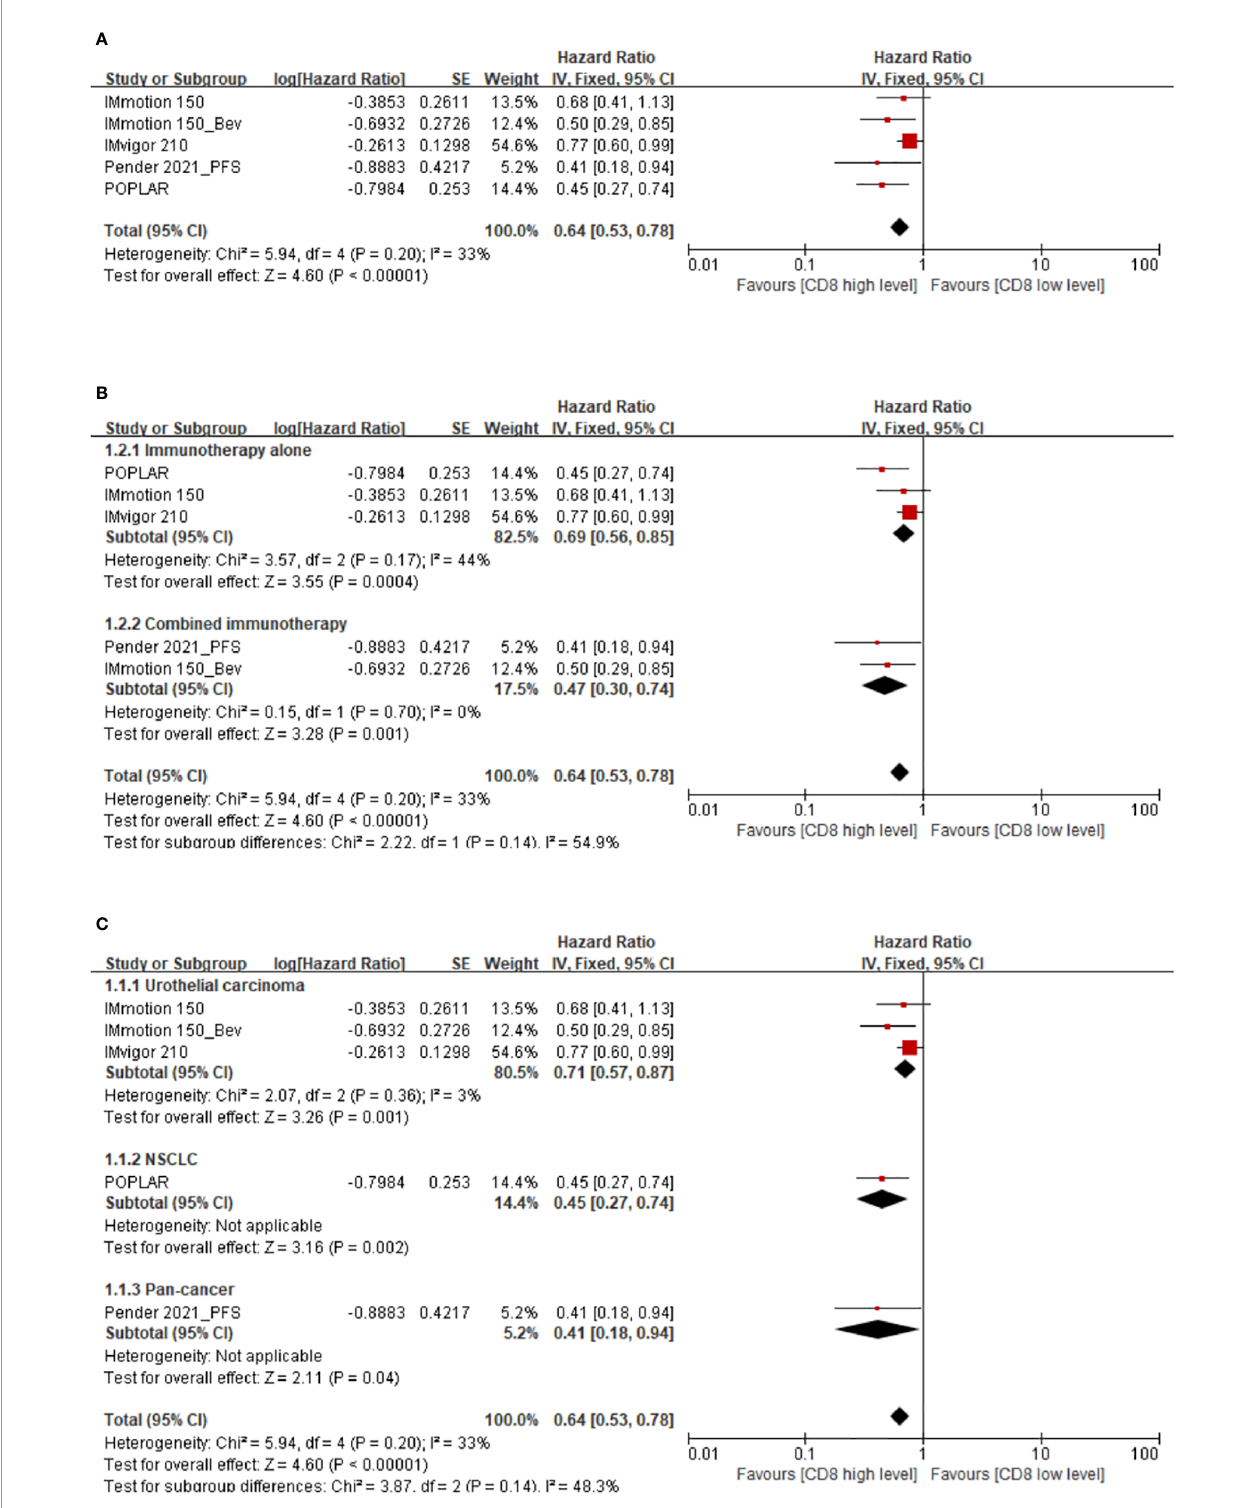
FIGURE 2 | (A) Florest plots of the fi xed-effects meta-analysis for the effects of memory CD8(+) T cells on PFS. (B) Forest plots of the fi xed-effects meta-analysis for the effects of the memory CD8(+) T cells on PFS in different treatment regimens. (C) Forest plots of the fi xed-effects meta-analysis for the effects of the memory CD8(+) T cells on PFS in different types of